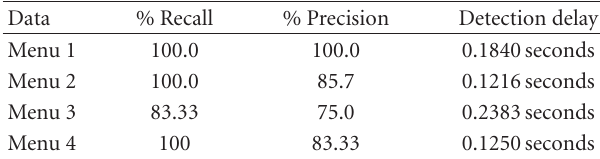
Table 5: Dancer 3 segmentation